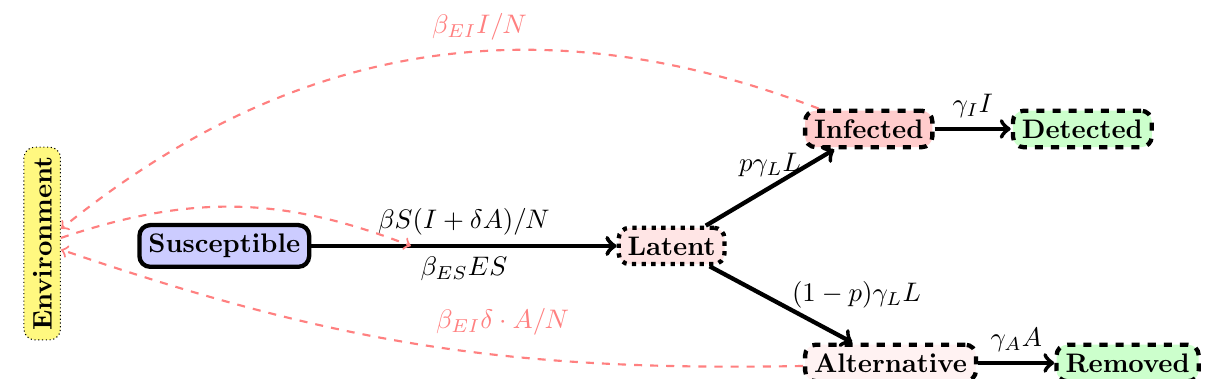
Figure 1. SLIADRE model: Schematic view of the SLIADRE model used in the simulations. Each compartment is indicated with a rectangular box and the flow of individuals or infection vectors with solid arrows. Dashed arrows indicate which compartment influences